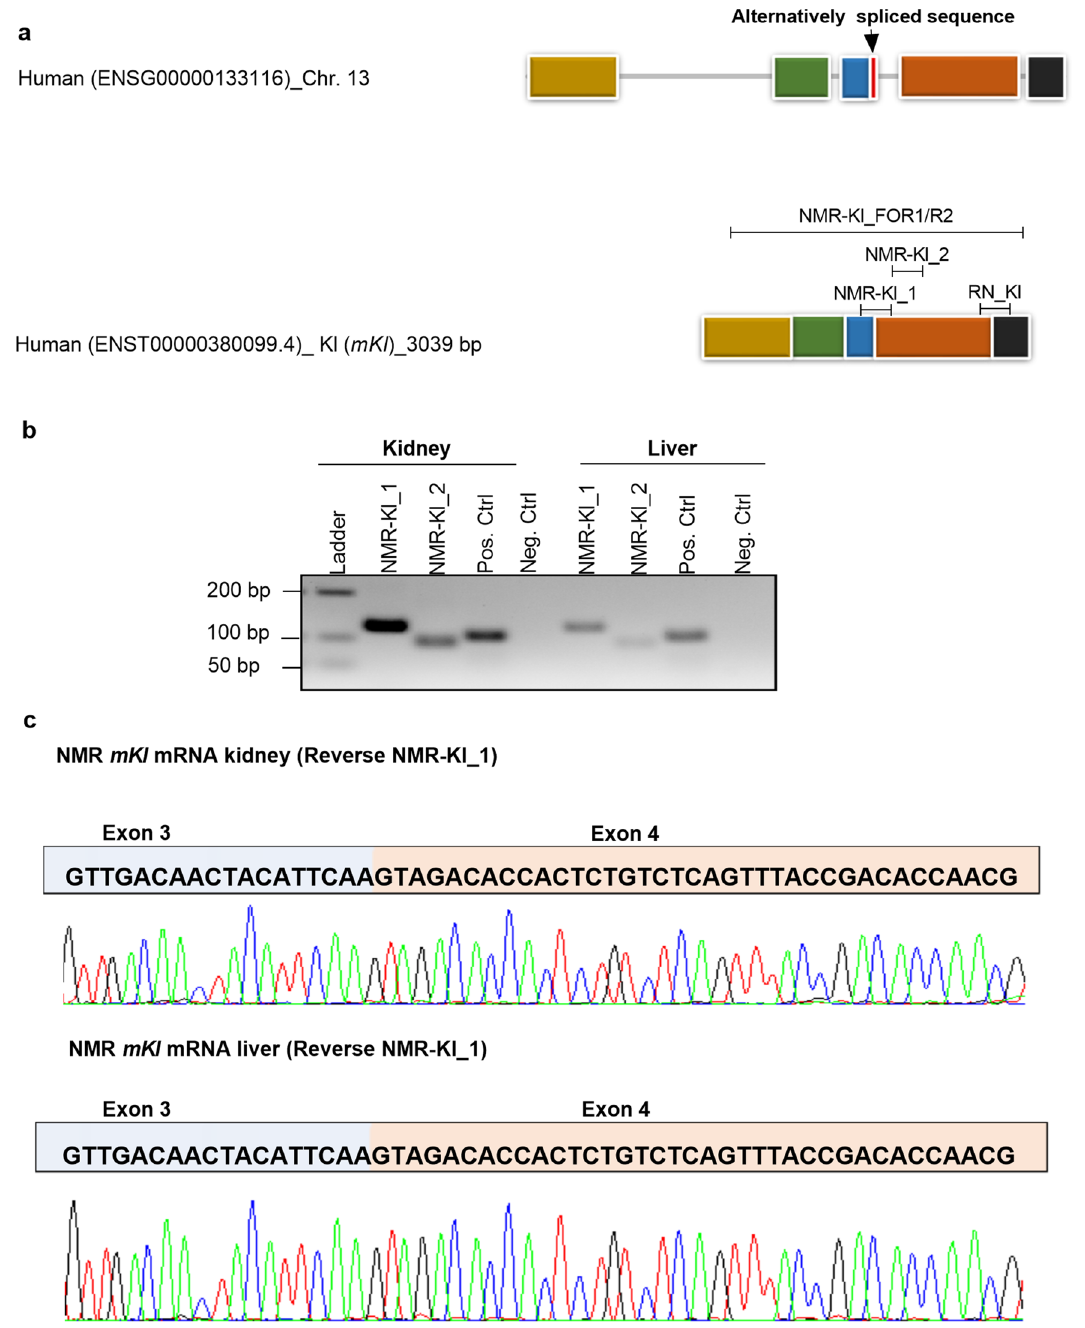
Figure 4. Identification of Kl -mRNA by PCR and Sanger sequencing in the Naked Mole Rat. ( a ) Architecture of the Kl in humans and locations of customized primers for the Naked Mole Rat (NMR) and Rattus Norvegicus (RN). The primers were designed in order to measure the expression of mKl in NMR (NMR-Kl_1 and 2) and RN (RN_Kl), The designed primers, specific for RN and NMR klotho are visualized in relation to the simplified illustration of well characterized human mRNA sequence. Line-box diagram showing the exon–intron arrangement for Human mKl . Boxes represent exons, while the black line represents introns; exon 1: yellow, exon 2: green, exon 3: blue, exon 4: orange; exon 5: black. Two transcripts of Kl have been found in humans. The red box represents part of the intron between exon three and four that is alternatively spliced in humans, yielding mRNA transcript known as s Kl . The black arrows denote the positions of the alternative spliced sequence. The location of the long-range PCR primer ( Kl_FOR1/ Kl_R2 ) used for identification of NMR tissue Kl (shown in Fig. 3) is depictured . ( b ) Identification of Kl mRNA by PCR and Sanger Sequencing in the NMR. Agarose gel electrophoresis displays PCR amplification of Kl mRNA in the kidney and liver of NMR measured by two primer sets with annealing to different positions on mKl . PCR using NMR-Kl_1 primer set spanning on part of exon 3 (corresponding to exon 3 and 4 in human, where alternative splicing has been found before) yields one PCR product, which indicates no alternative splicing in NMR liver and kidney. ( c ) Sanger Sequencing shows that the Kl sequence in the liver is identical to that of the kidney in NMR. NMR: Naked Mole Rat; RN: Rattus Norvegicus; Kl : klotho